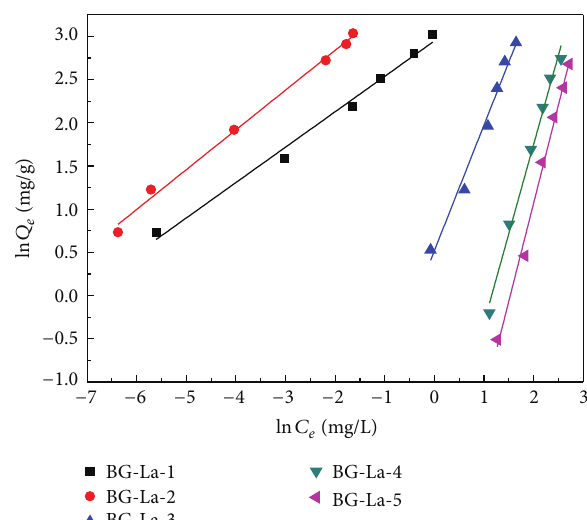
Figure 8: The pseudo-first-order kinetics of MB by BG-La.